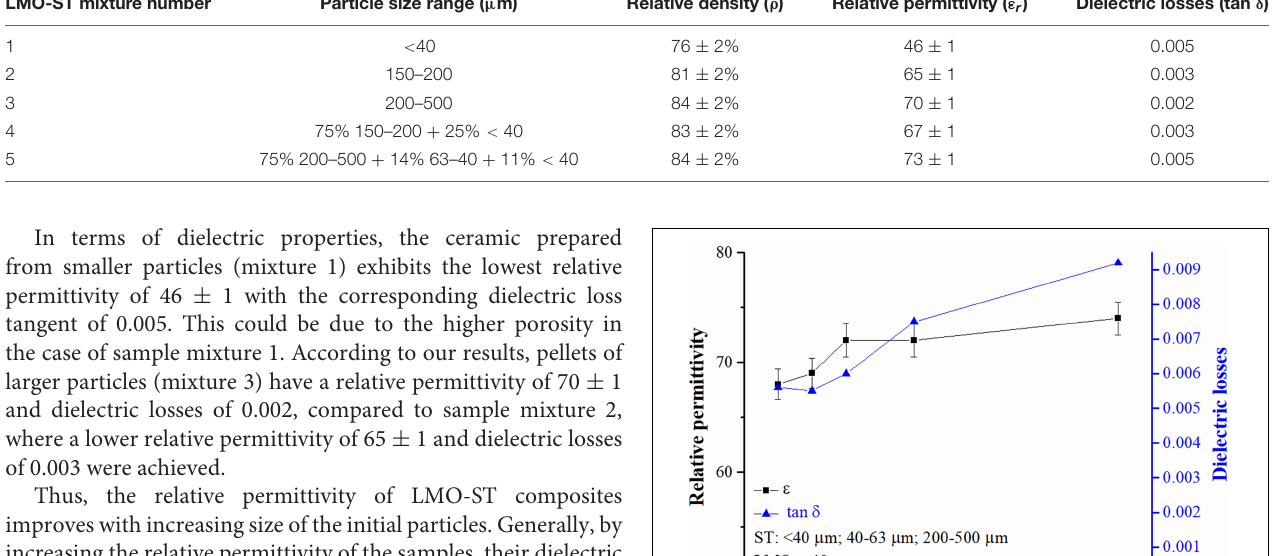
TABLE 1 | The effect of ST particle size fractions on the relative density and dielectric properties of LMO-ST composites fabricated at RT and measured at 1 MHz. LMO-ST mixture number Particle size range ( µ m)